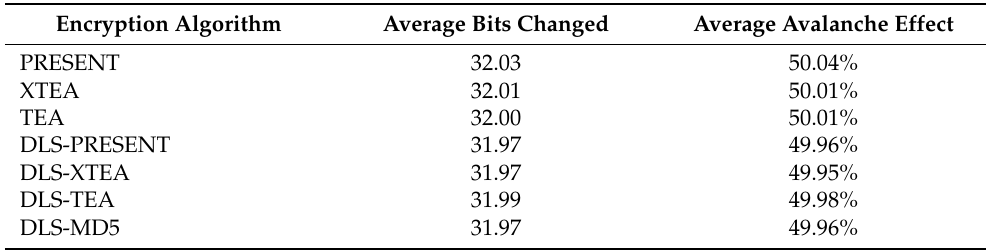
Table 5. A summary of the average number of bits changed and the avalanche effect measured over 50,000 random encryption keys.